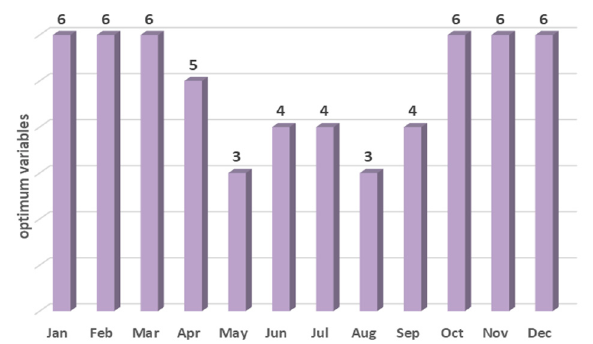
Figure 7. Number of optimum geophysical variables used as predictors each month. Table 1. Geophysical variables used as precipitation predictors (PC-1 to PC-15 correspond to the first fifteen principal components proposed by the AURELHY method).